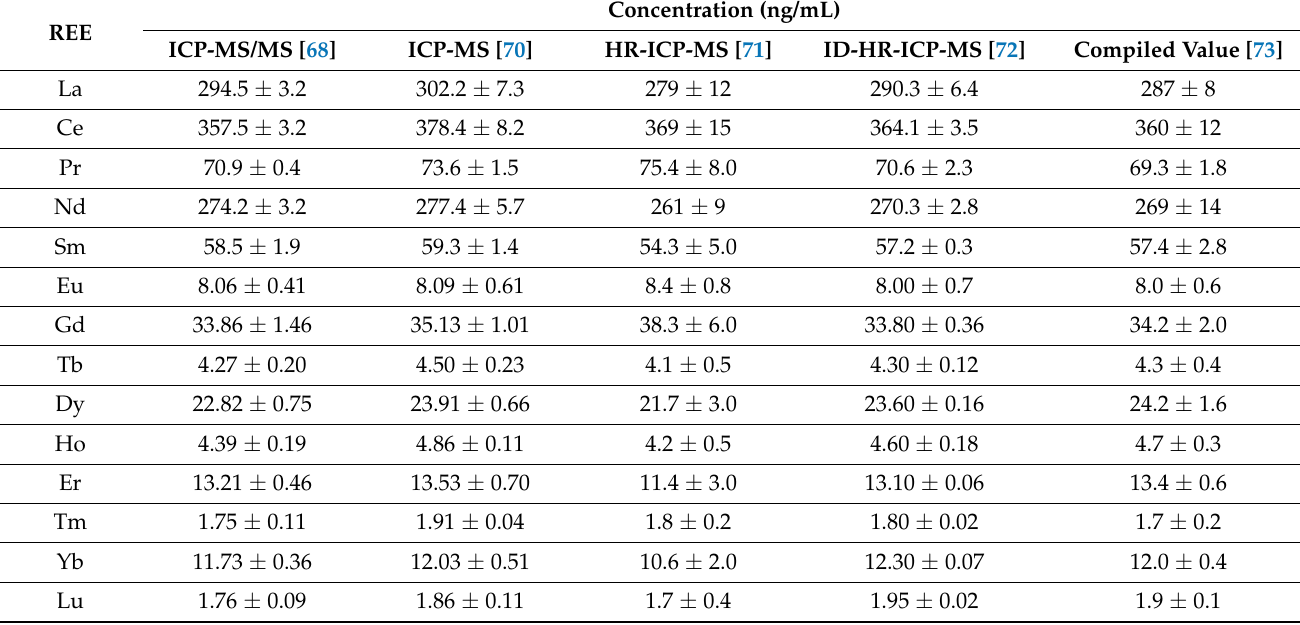
Table 7. The analytical results of REE in water reference material, SLRS-4 obtained by different well-established analytical techniques in comparison with those obtained by